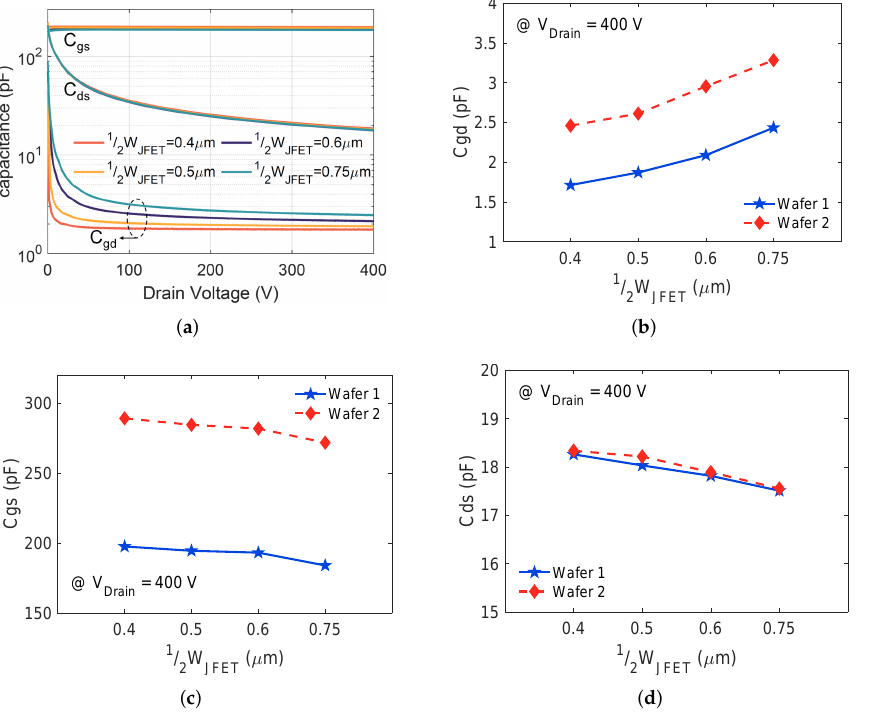
Figure 6. ( a ) Measured device capacitances vs. drain voltage at 100kHz of the SiC MOSFETs on wafer 1, ( b ) C gd , ( c ) C ds , and ( d ) C gs variation as a function of 1 and